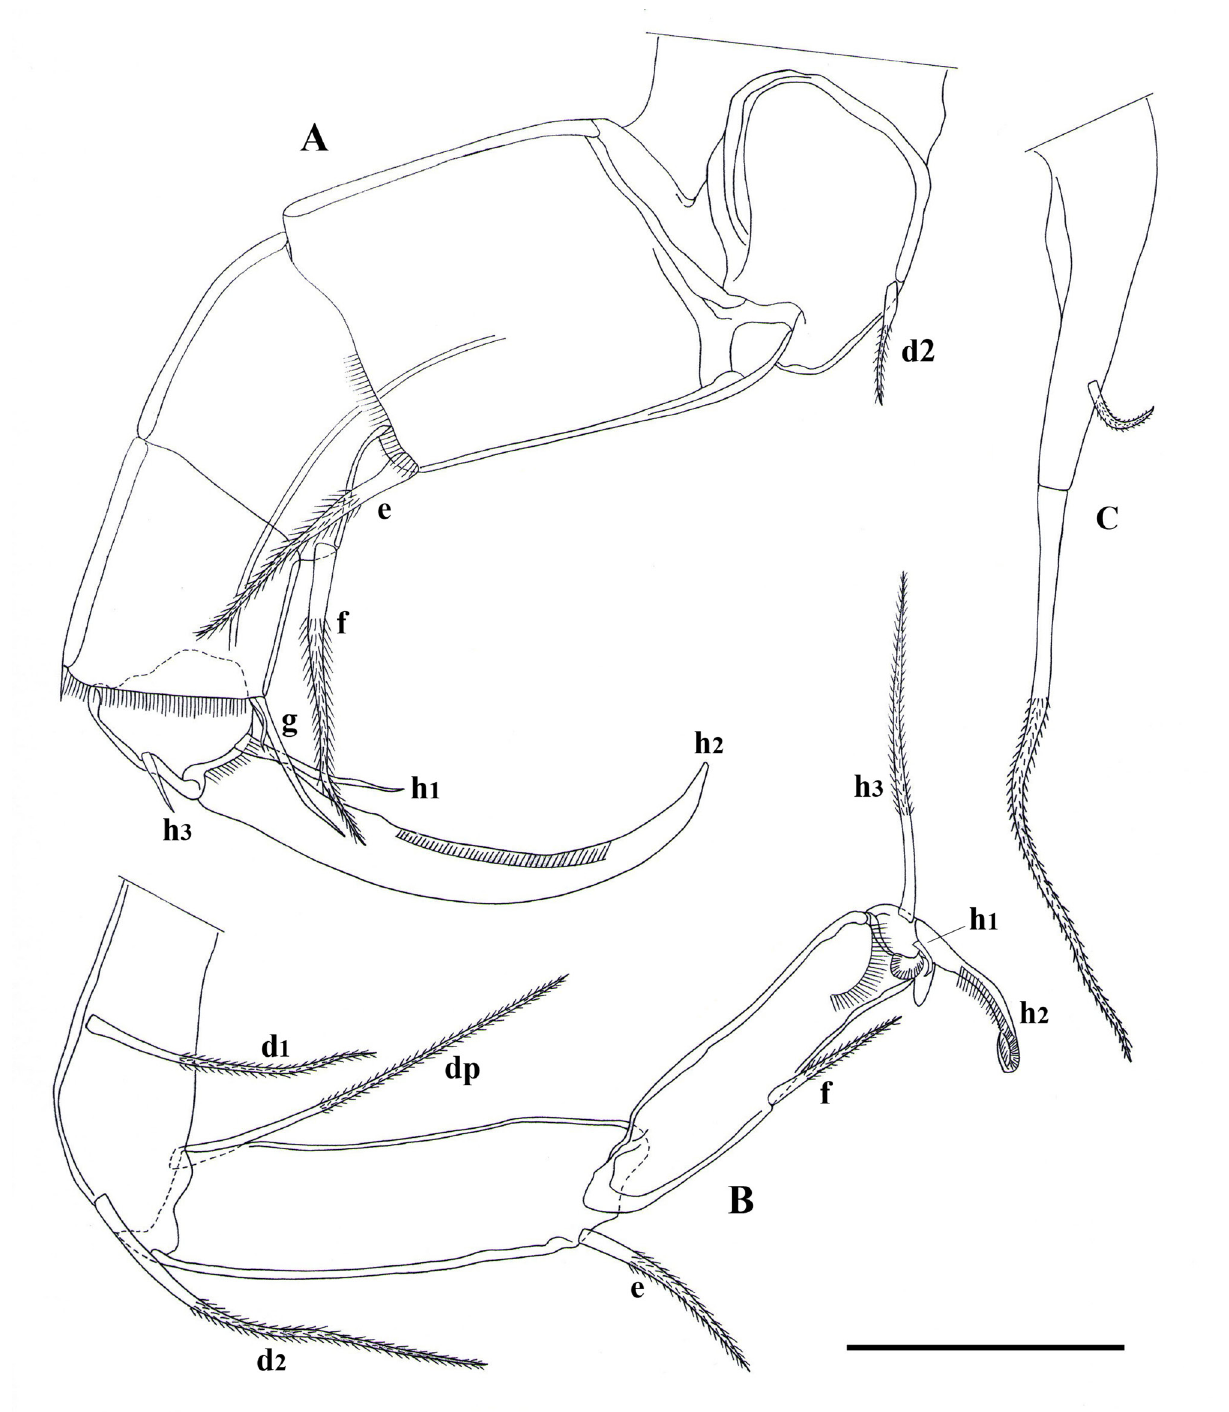
Fig. 4. Siamopsis renateae gen. et sp. nov., ♀ (MSU-ZOC.190). A . T2. B . T3. C . CR. Scale bar: 50 μm.